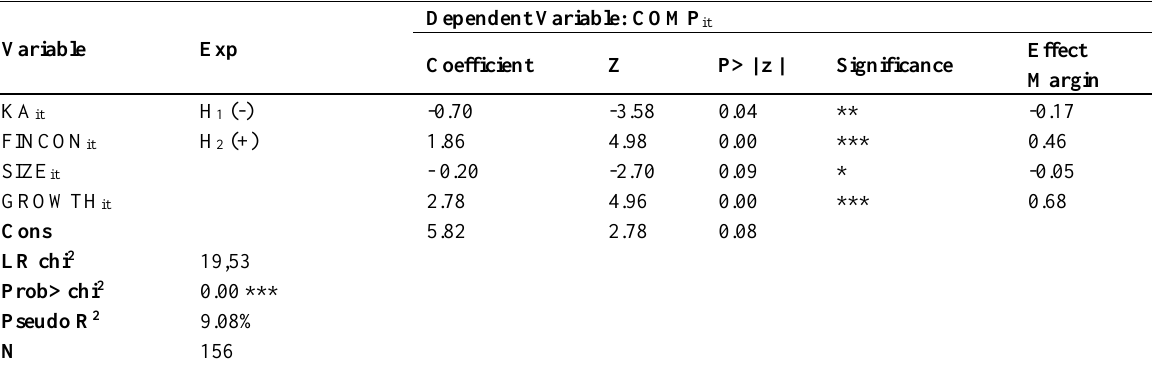
Table 3 : Logistic regression determines the complementary level of financial and tax